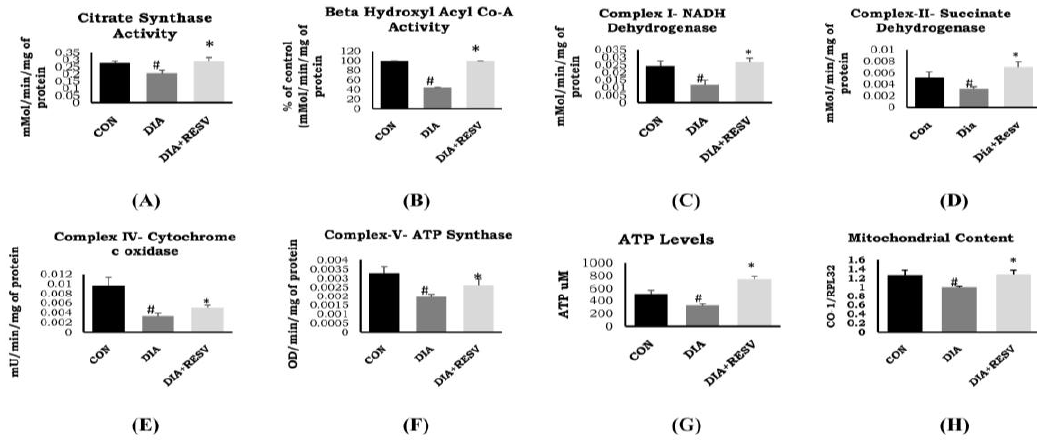
Figure 2. Mitochondrial metabolic enzymes activity in diabetic rat heart and effect of resveratrol administration . ( A ) Citrate synthase; ( B ) β -hydroxy acyl CoA dehydrogenase; ( C ) Complex-I: NADH dehydrogenase; ( D ) Complex-II: Succinate dehydrogenase; ( E ) Complex-IV: Cytochrome c oxidase; ( F ) Complex-V: ATP synthase; ( G ) ATP levels; ( H ) Mitochondrial content. Data shown as mean ± SE, ( n = 6) # p < 0.05 vs. Con; * p < 0.05 vs. DIA group.